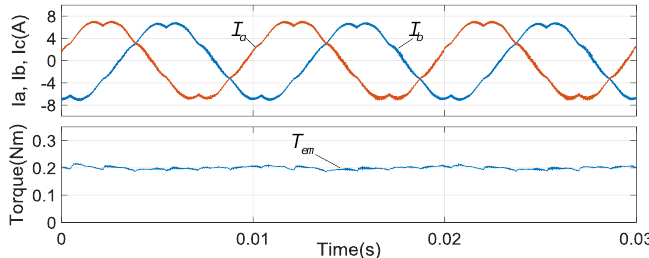
Figure 11. Test waveforms at the speed of 3000 r/min with COC.